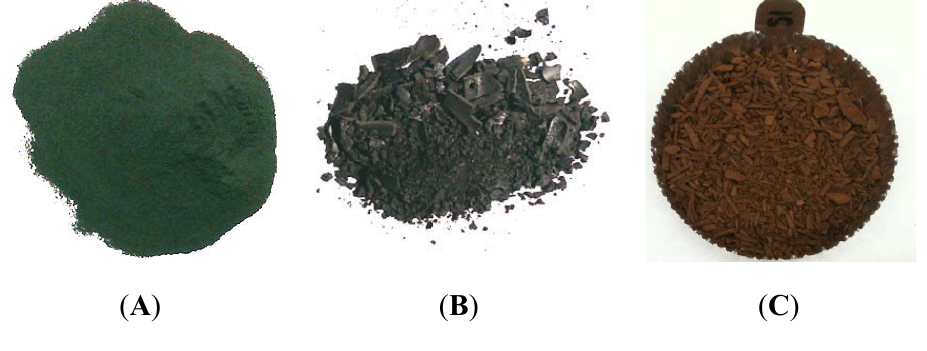
Figure 2. Photos of ( A ) raw Spirulina ; ( B ) Hydrochar from Spirulina at 175 °C and ( C ) Hydrochar from loblolly pine at 235